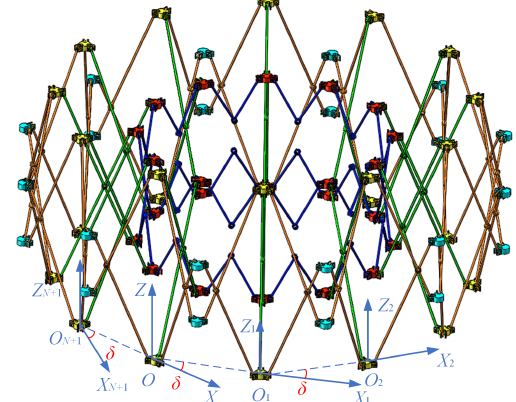
Figure 14. Deployable mechanism and coordinate system of the scissor multi-rod